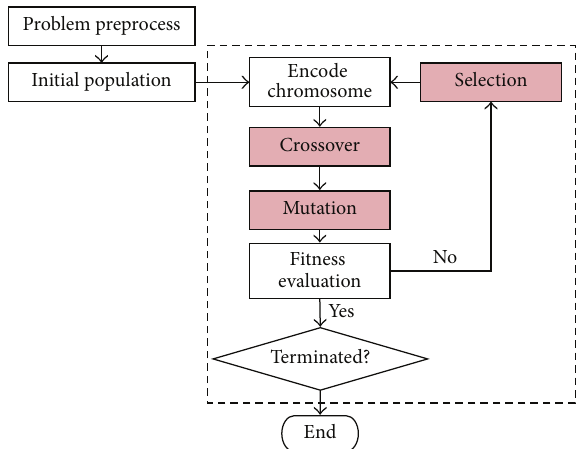
Figure 3: The relationship between itemsets before and after the PPUM